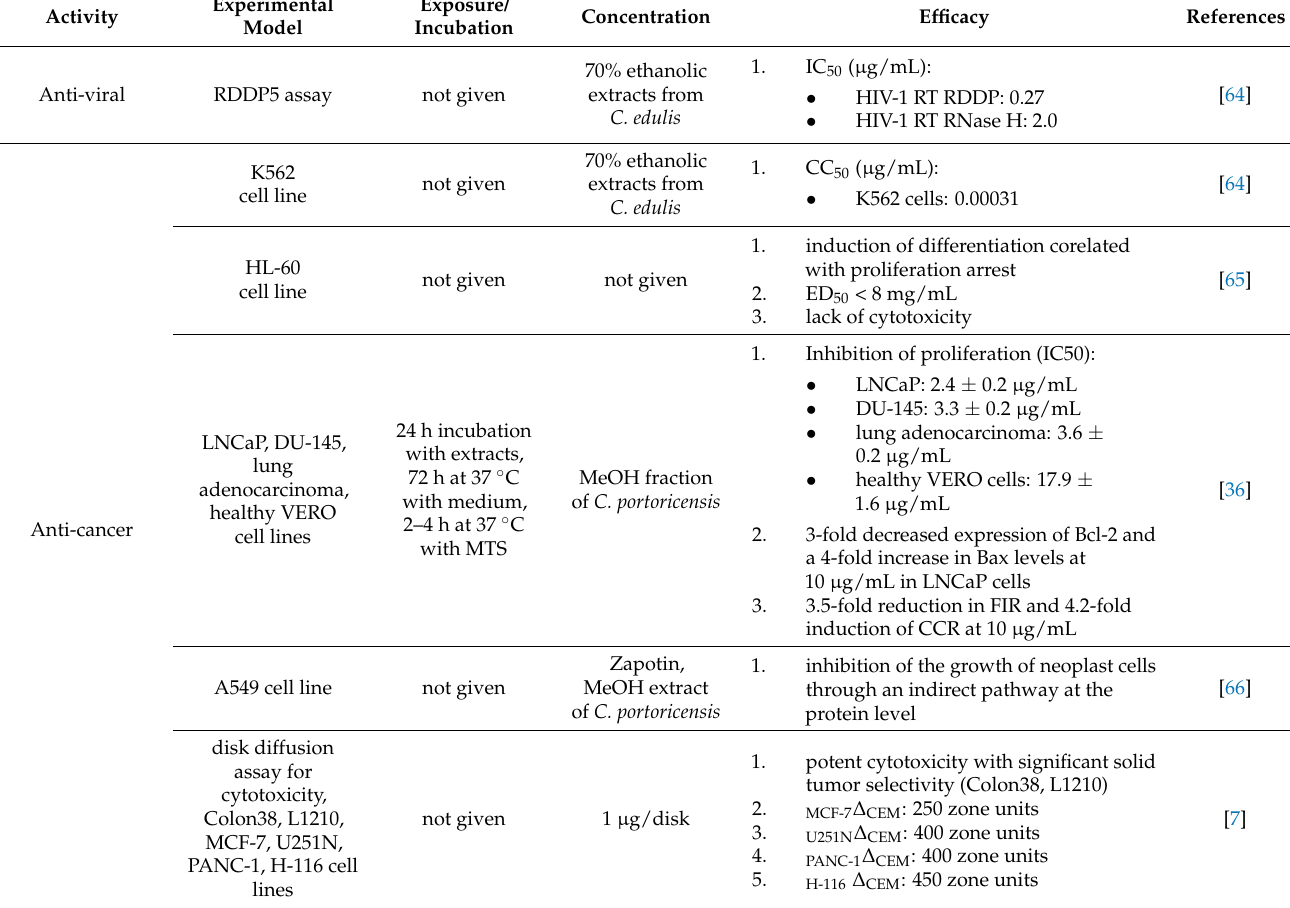
Table 5. Bioactivities of zapotin reported in experimental models in vitro and in